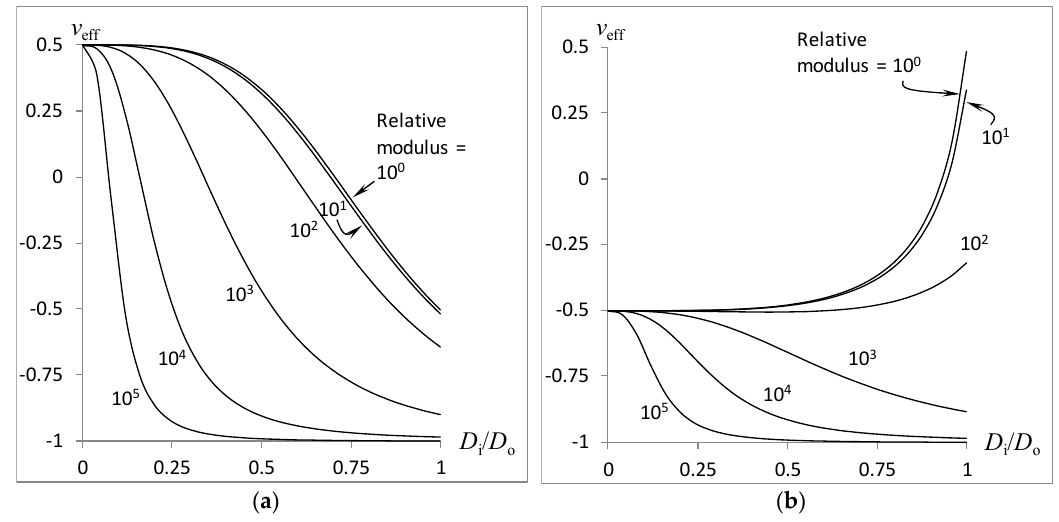
Figure 4. Effect of relative adhesive modulus on the compound rod auxeticity: ( a ) Auxetic core; ( b ) Auxetic shell.